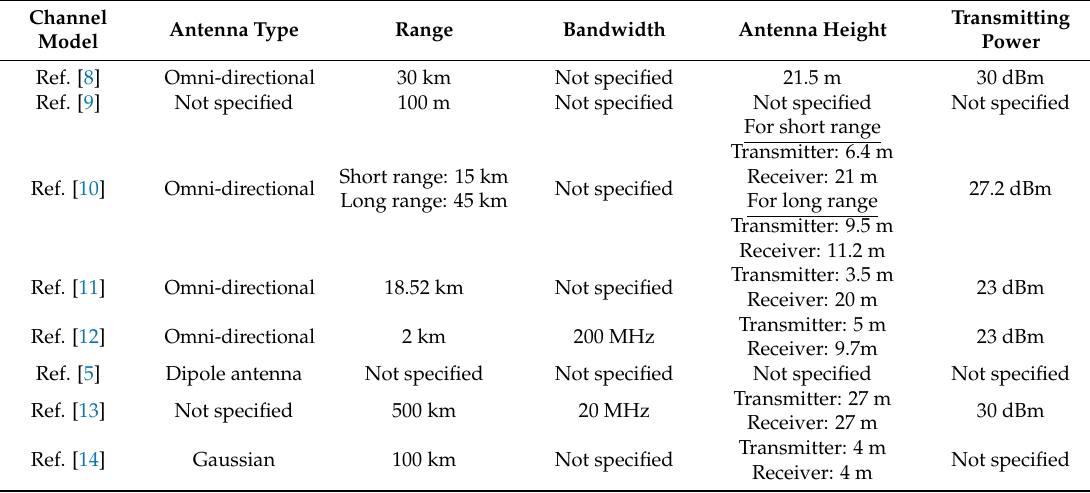
Table 3. Comparison of antenna specification and